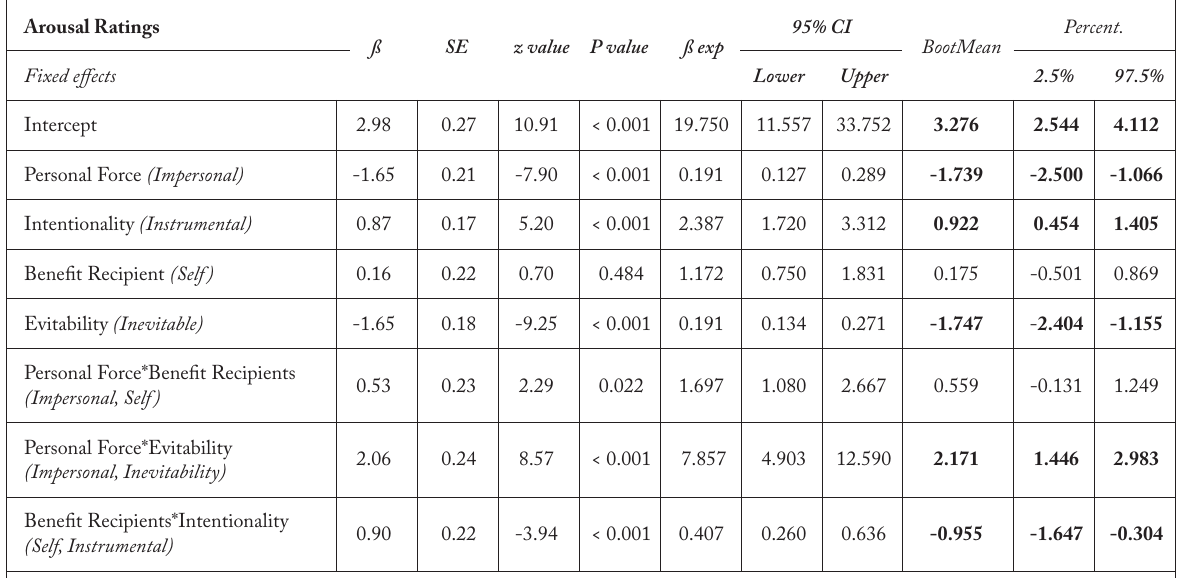
Table 3. Summary of the best linear mixed effects models on arousal ratings for Study 2. Higher ß values indicate higher arousal